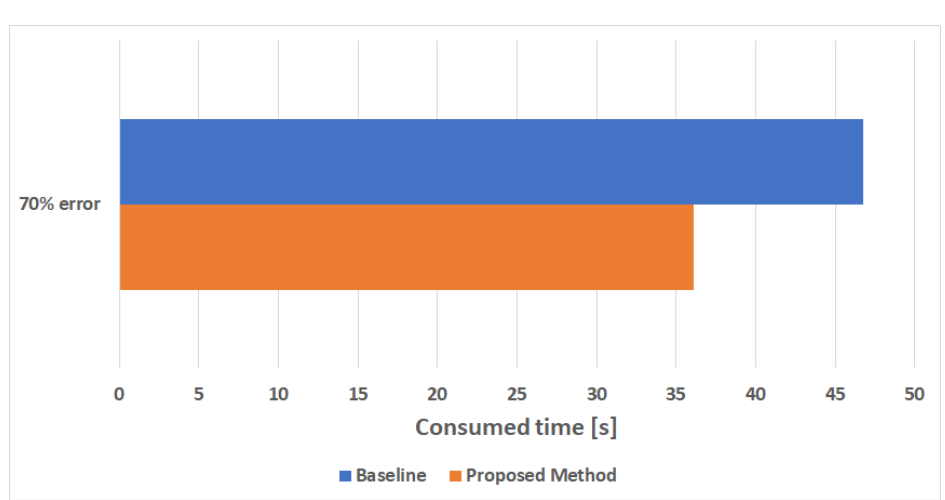
Figure 27. Load Testing—with 70% error.